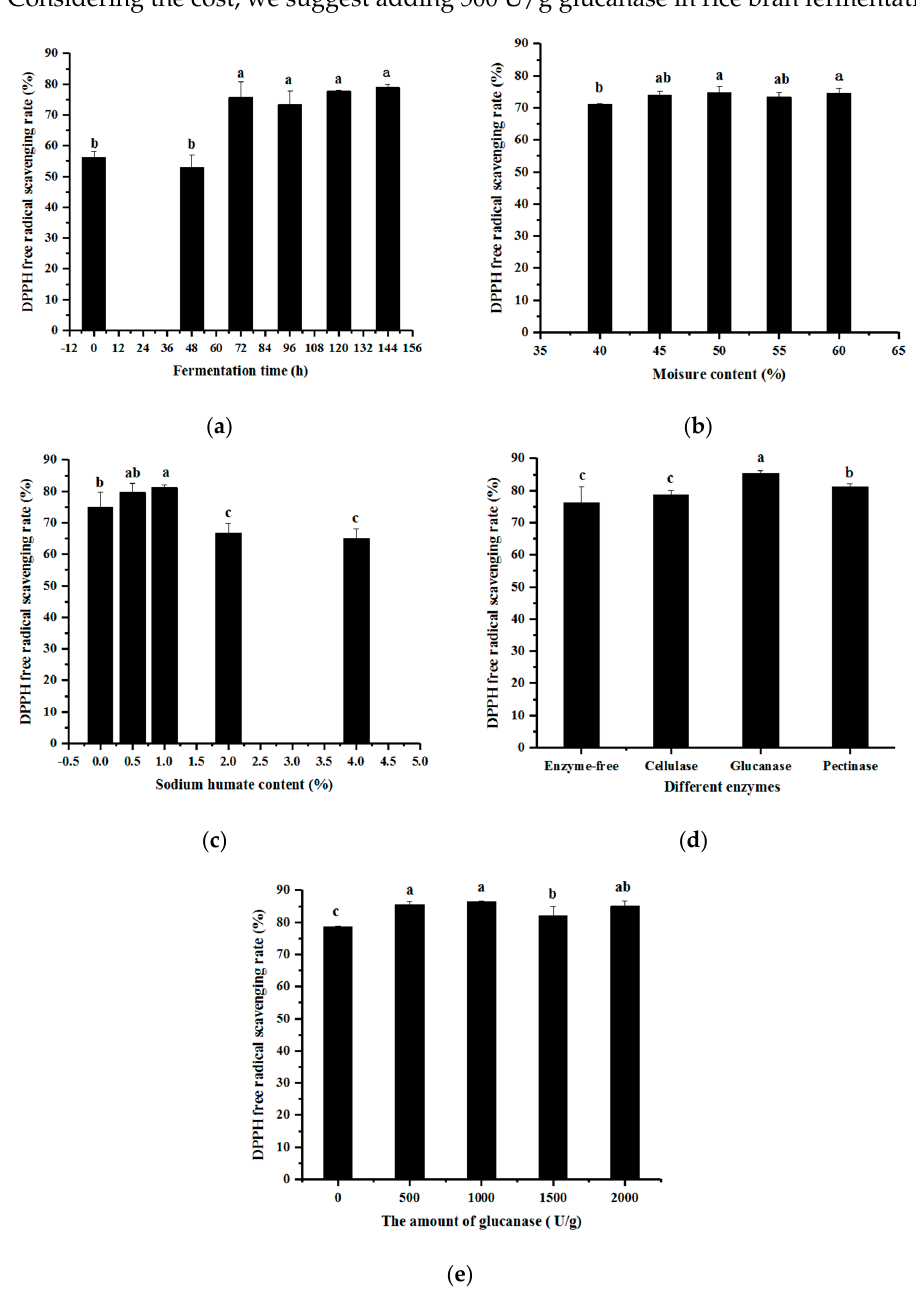
Figure 1. Effect of different fermentation technologies on the DPPH free radical scavenging rate of rice bran. Columns not sharing a common letter showed significant differences ( p < 0.05). ( a ) Fermentation time, h; ( b ) moisture content, %; ( c ) sodium humate content, %; ( d ) different enzymes; ( e ) the amount of glucanase, U/g.